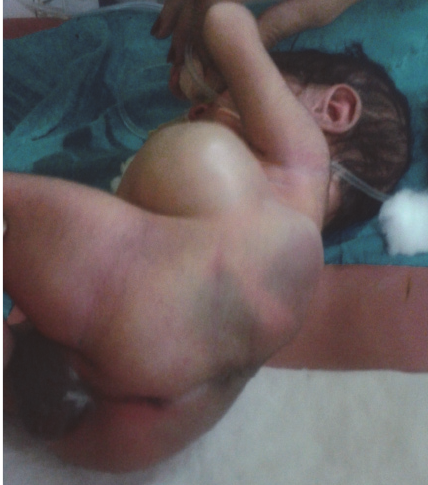
Figure 2: Left congenital lumbar hernia with ARM and vertebral defect.